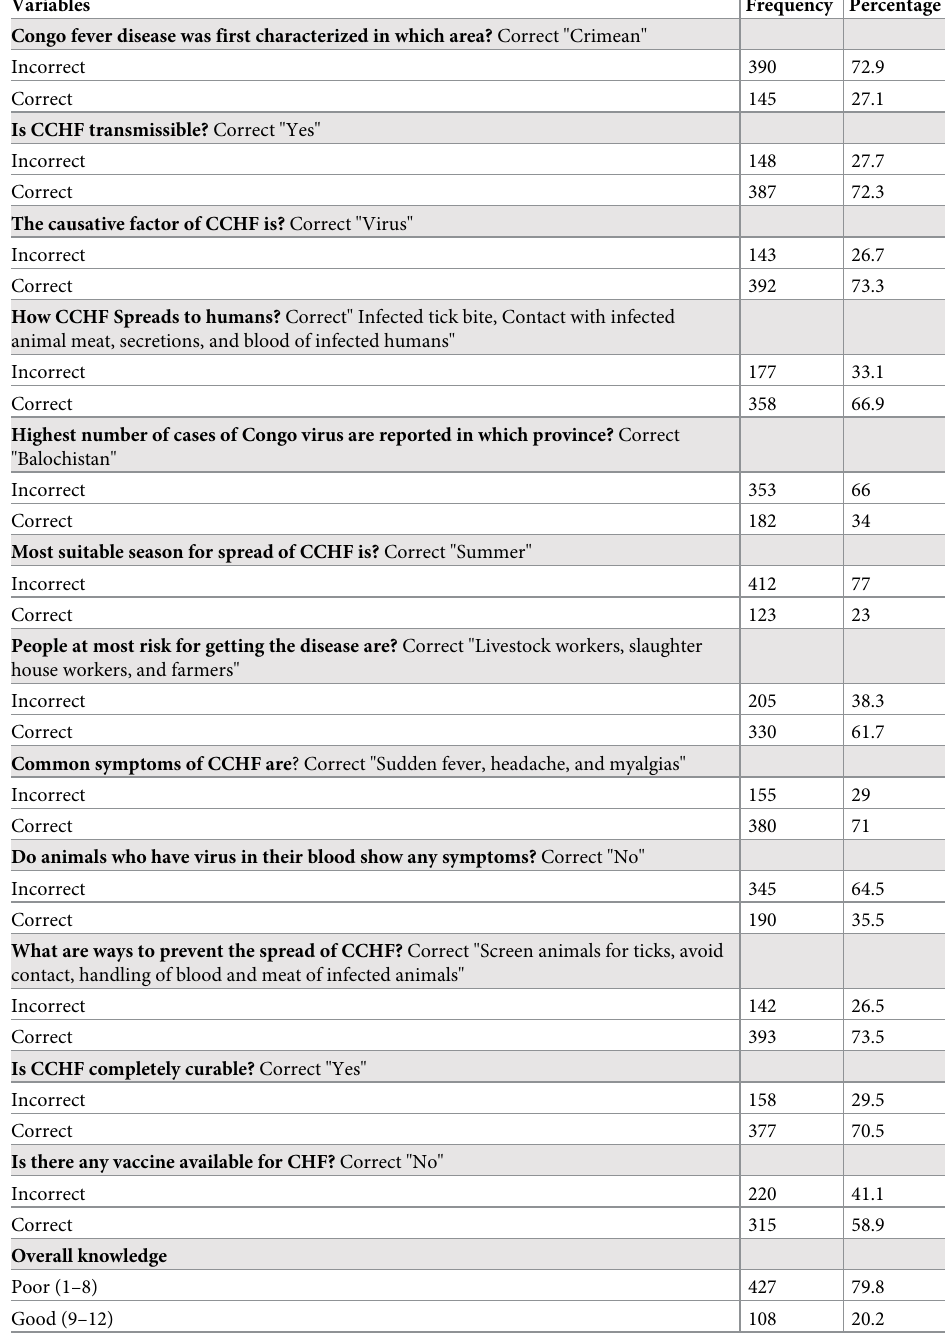
Table 3. Knowledge among general people regarding Congo ( N =